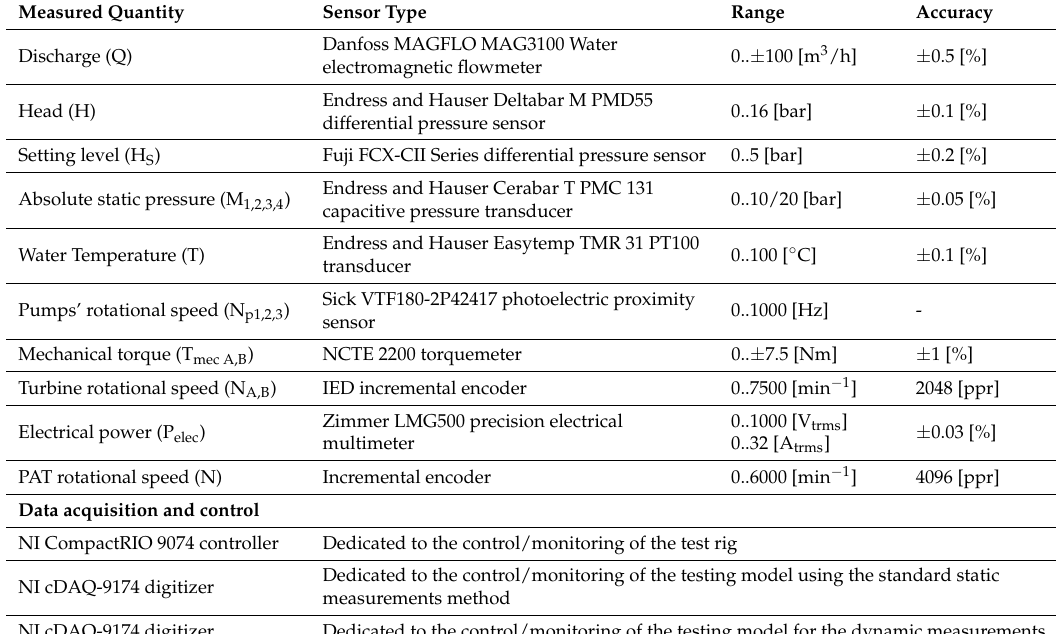
Table 1. Main characteristics of the employed instruments for performance measurements.